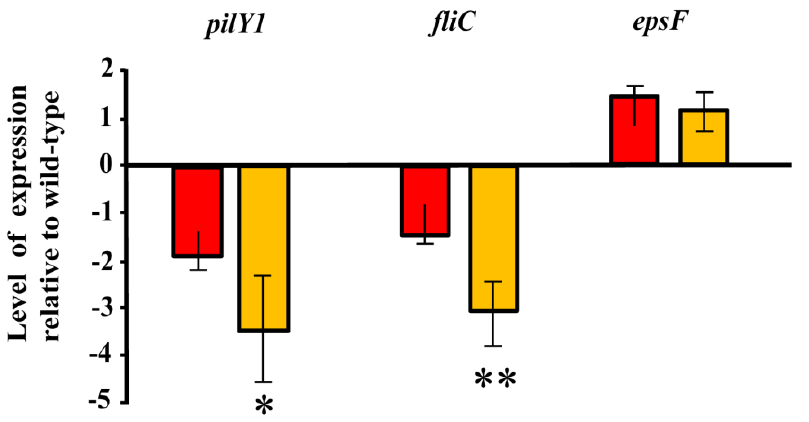
Figure 6. Expression of the pilY1 , fliC and epsF genes in Azoarcus sp. CIB strains producing different levels of c-di-GMP. The transcript levels of the pilY1 , fliC and epsF genes in the Azoarcus sp. CIB (pIZ2133) ( red columns ) and Azoarcus sp. CIB (pIZ4959) ( yellow columns ) strains grown in VM-ethanol medium for 24 h, were determined by quantitative RT-PCR using dnaE gene as internal control, as detailed in Methods. The expression of the genes in each strain is shown relative to their expression in the control strain Azoarcus sp. CIB (pIZ1016). The mean value and the standard deviation corresponding to the results of three independent experiments are indicated. Values of expression of pilY gene ( p = 0.0174) in Azoarcus sp. CIB (pIZ2133) and Azoarcus sp. CIB (pIZ4959), were significantly different ( p = 0.0174; one asterisk). Values of expression of fliC gene in Azoarcus sp. CIB (pIZ2133) and Azoarcus sp. CIB (pIZ4959), were very significantly different ( p = 0.0095; two asterisks). Values of expression of epsF gene in Azoarcus sp. CIB (pIZ2133) and Azoarcus sp. CIB (pIZ4959) were not significantly different ( p = 0.0516). All the statistic data were obtained according to unpaired t -test.